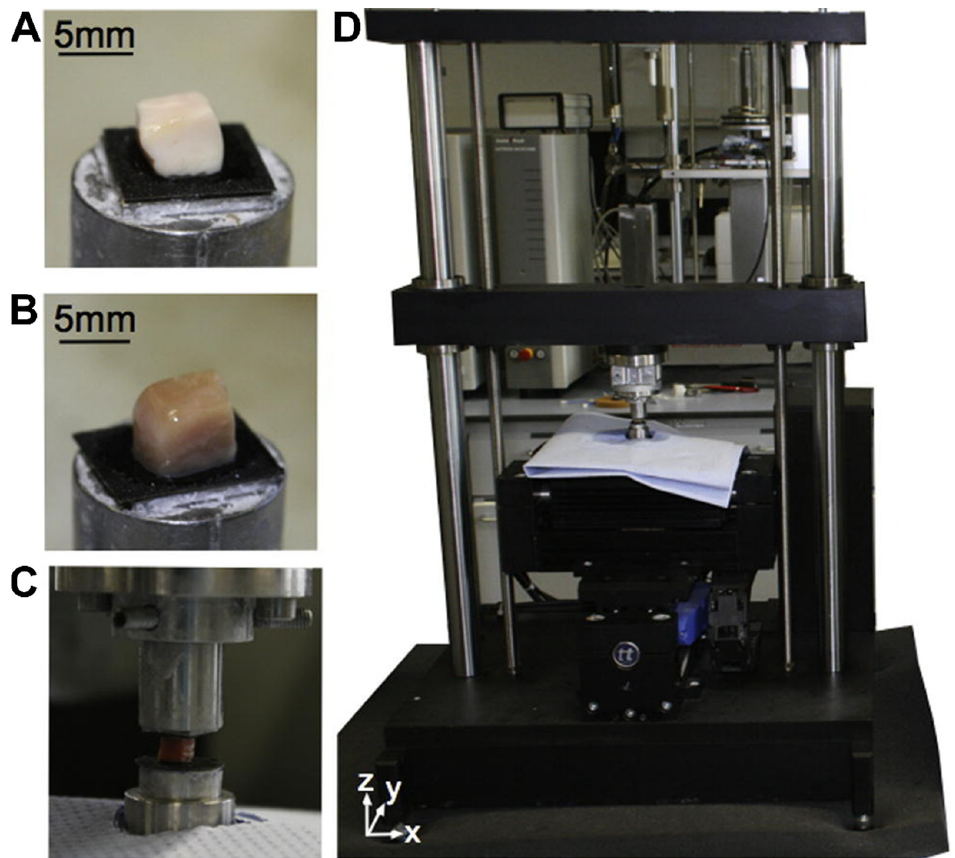
Figure 4. Rheological measurement setup. ( A ) White matter sample; ( B ) gray matter sample; ( C ) sample glued to upper and lower plates; ( D ) hydrated sample mounted into device. Figure adapted with permission from Ref. [120] . 2017, Budday S.